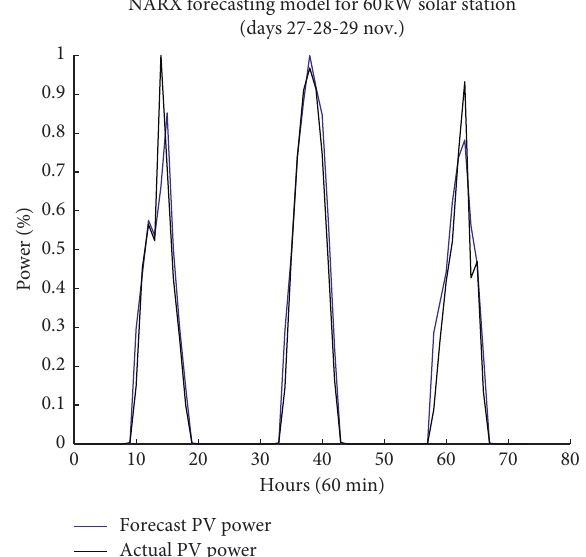
Figure 14: NARX neural network for forecasting days 27, 28, and 29 November of the